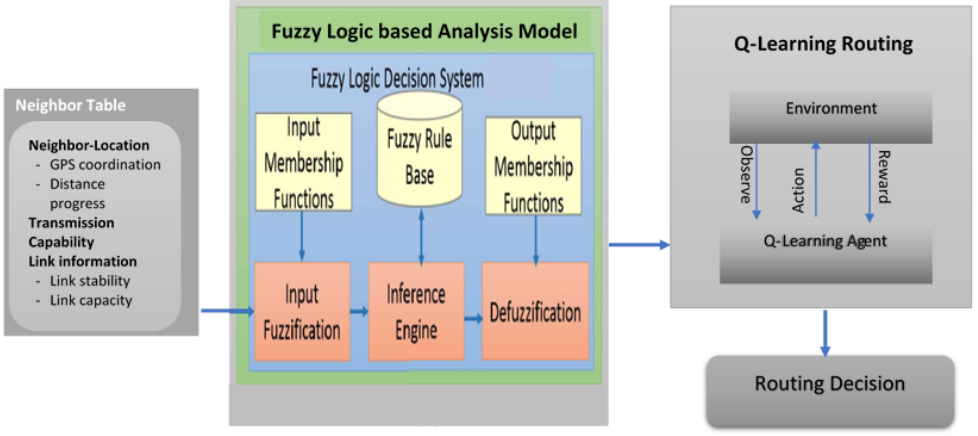
Figure 2. FQ-AGO system